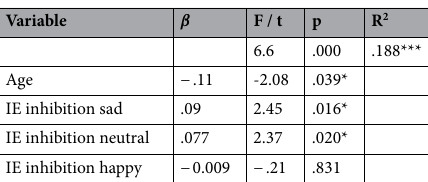
Table 3. A hierarchical linear regression analysis for prediction of depression level (PHQ-9 total score) from IE task parameters. *p < 0.05, ***p < 0.001.